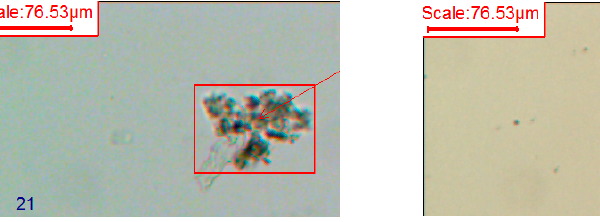
Figure 5 . Microscopic image and the measurement of the size of the flock (magnification 100×) .